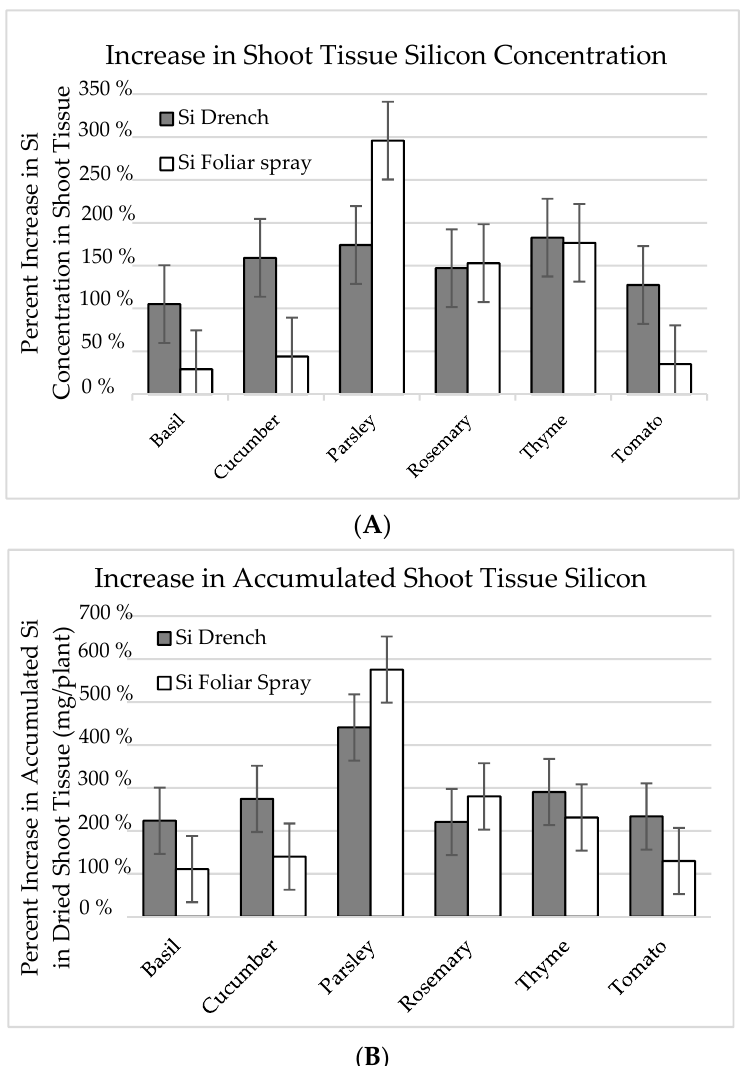
Figure 2. Silicon (Si) treatment effects on the percent increase in shoot tissue Si ( A ) and accumulated Si ( B ) relative to the control treatments at the end of production for six container-grown edible species. Silicon foliar spray (500 mg ∙ L –1 Si), substrate drench (100 mg ∙ L –1 Si), and control (0 mg ∙ L –1 Si) treatments were applied every 7 d during production. Data represent least-square means of three replicates, and error bars represent 95% confidence intervals.